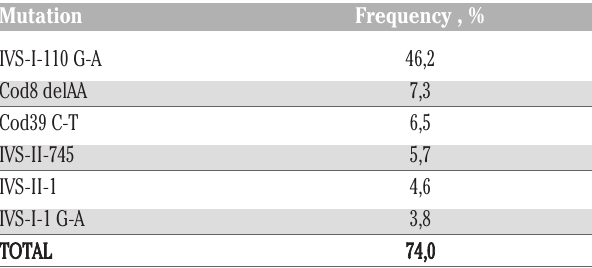
Table 3. The most frequent β -Thalassemia mutations in our sam- ple population.